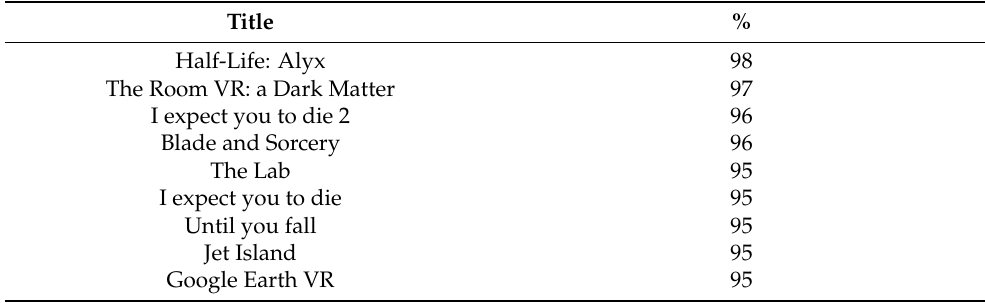
Table 7. VR applications with “overwhelmingly positive” reviews in the category of adventure VR apps [state on 6 July 2022].